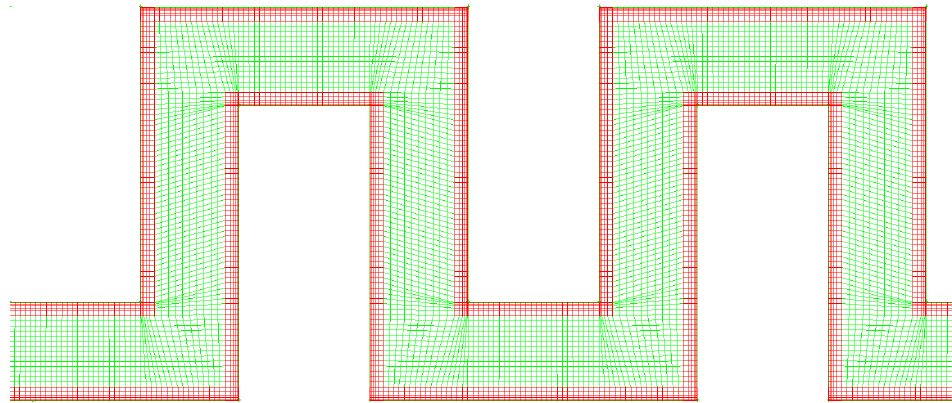
Figure 3. Grid division of the emitter.